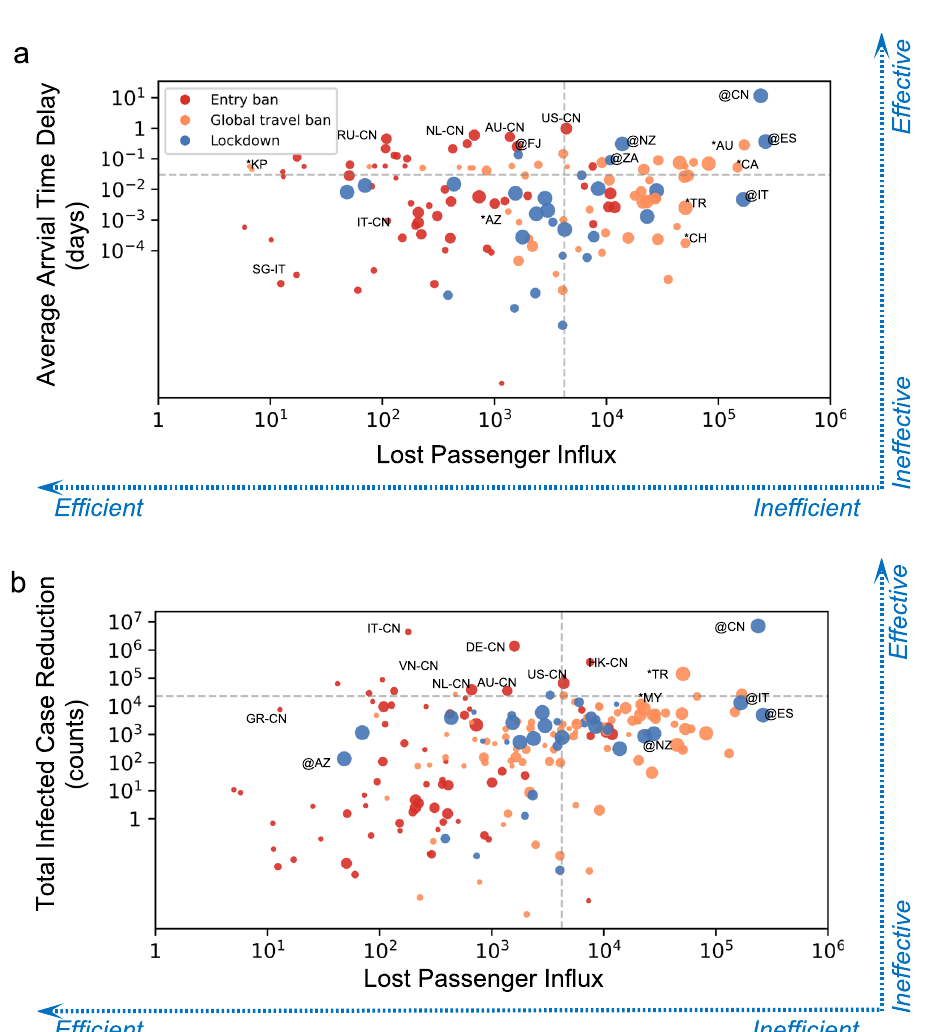
Fig. 4 Effectiveness and ef fi ciency of existing travel restrictions. a , b depict existing travel restrictions ’ arrival time delay (ATD) and infected case reduction (ICR) at the cost of losing passenger in fl ux. Effective and ef fi cient travel restrictions pursue high ATD or ICR with a low cost of passenger in fl ux. Circles represent travel restrictions, and their size is proportional to the number of geographical areas in fl uenced by the travel restrictions. The vertical and horizontal dashed lines individually represent the average of lost passenger in fl ux and the average of total ATD/ICR for all travel restrictions. The markers for travel restrictions are the same as those in Fig. 3. The two-letter codes for geographical areas can be found in Supplementary Table